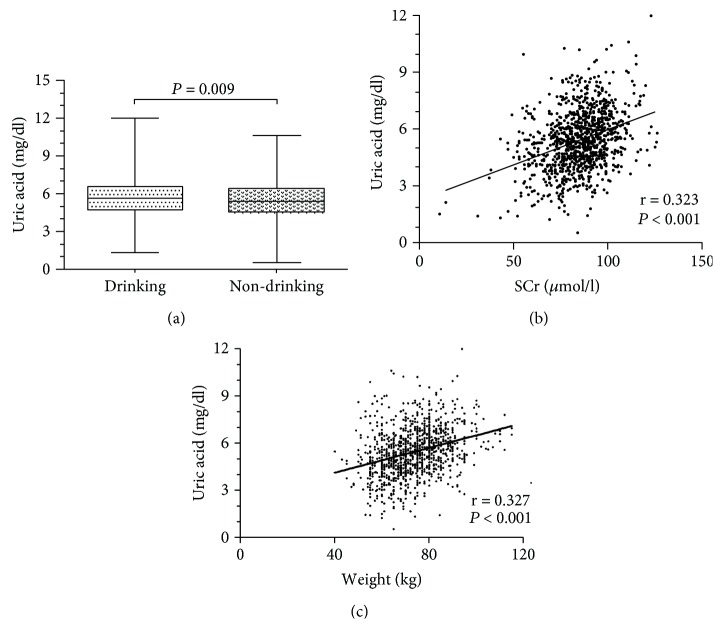
The influence factors of serum uric acid levels in EOCAD patients. (a) Male controls with drinking status (5.713 ± 1.505 mg/dl) had significantly higher serum uric acid levels than male controls without drinking status (5.463 ± 1.483 mg/dl, unpaired t-test, P = 0.009). (b) Correlation between serum uric acid and SCr in EOCAD patients (r = 0.323, P < 0.001). (c) Correlation between serum uric acid and weight in controls (r = 0.327, P < 0.001).